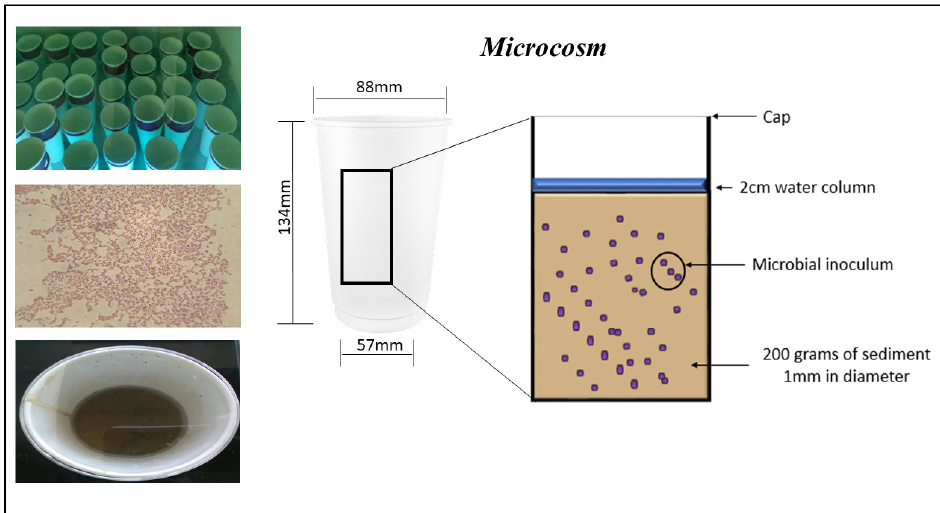
Figure 5. Microcosm set up to establish the efficacy of microbial isolates C3, C6, C7, C18, C21 and C22. Each microcosm includes 200 g of spiked sediment with 100 ng/g of tributyltin chloride and a 2-cm water column which was aspeticaly inoculated with 10 mL of an overnight culture in nutrient broth of an individual isolate and